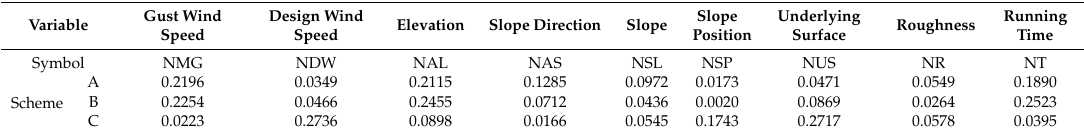
Table 2. Each variable importance weight evaluation result.